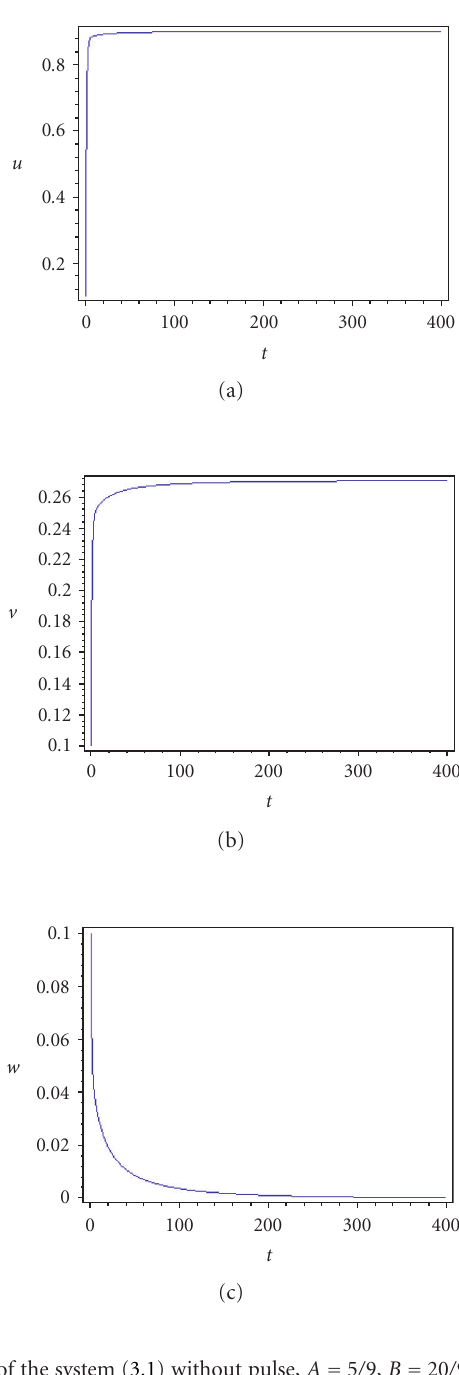
Figure 5.3. Time series of the system (3.1) without pulse, A = 5 / 9, B = 20 / 9, p = 0 . 54, Q = 0 . 9, and T =